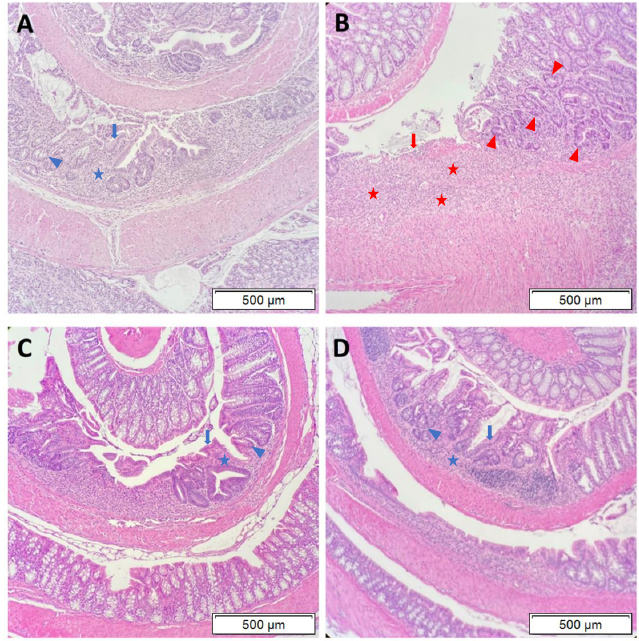
Figure 5. Representative hematoxylin and eosin (H&E) stained sections of colon histopathology. ( A ) WT with DSS exposure. Patchy areas of ulceration were noted, with evidence of re-epithelialization, indicating wound healing processes (blue arrows). In addition to these areas of ulceration, there are moderate areas of inflammatory infiltration (blue stars). Adjacent to these areas, gland architecture is modestly distorted with reactive atypia (nuclear enlargement, hyperchromasia, and prominent nucleoli) (blue triangular arrowheads). ( B ) WT with DSS + MC-LR exposure. Large areas of ulceration were noted, with an absence of re-epithelialization, indicating an inhibition of wound healing processes (red arrows). In addition to these large areas of ulceration, there is heavy inflammatory infiltration with fibrin deposition (red stars). Adjacent to these areas, gland architecture is severely distorted with aggressive reactive atypia in the gland architecture (red triangular arrowheads). ( C ) CD40KO with DSS exposure. Patchy areas of ulceration were noted, with evidence of re-epithelialization, indicating wound healing processes (blue arrows). In addition to these areas of ulceration, there are moderate areas of inflammatory infiltration (blue stars). Adjacent to these areas, gland architecture is modestly distorted with reactive atypia (blue trianglular arrowheads). ( D ) CD40KO with DSS + MC-LR exposure. Patchy areas of ulceration were noted, with evidence of re-epithelialization, indicating wound healing processes (blue arrows). In addition to these areas of ulceration, there are moderate areas of inflammatory infiltration (blue stars). Adjacent to these areas, gland architecture is modestly distorted with reactive atypia (blue trianglular arrowheads). All images were taken at 10 × objective. Scale bars indicate 500 µ